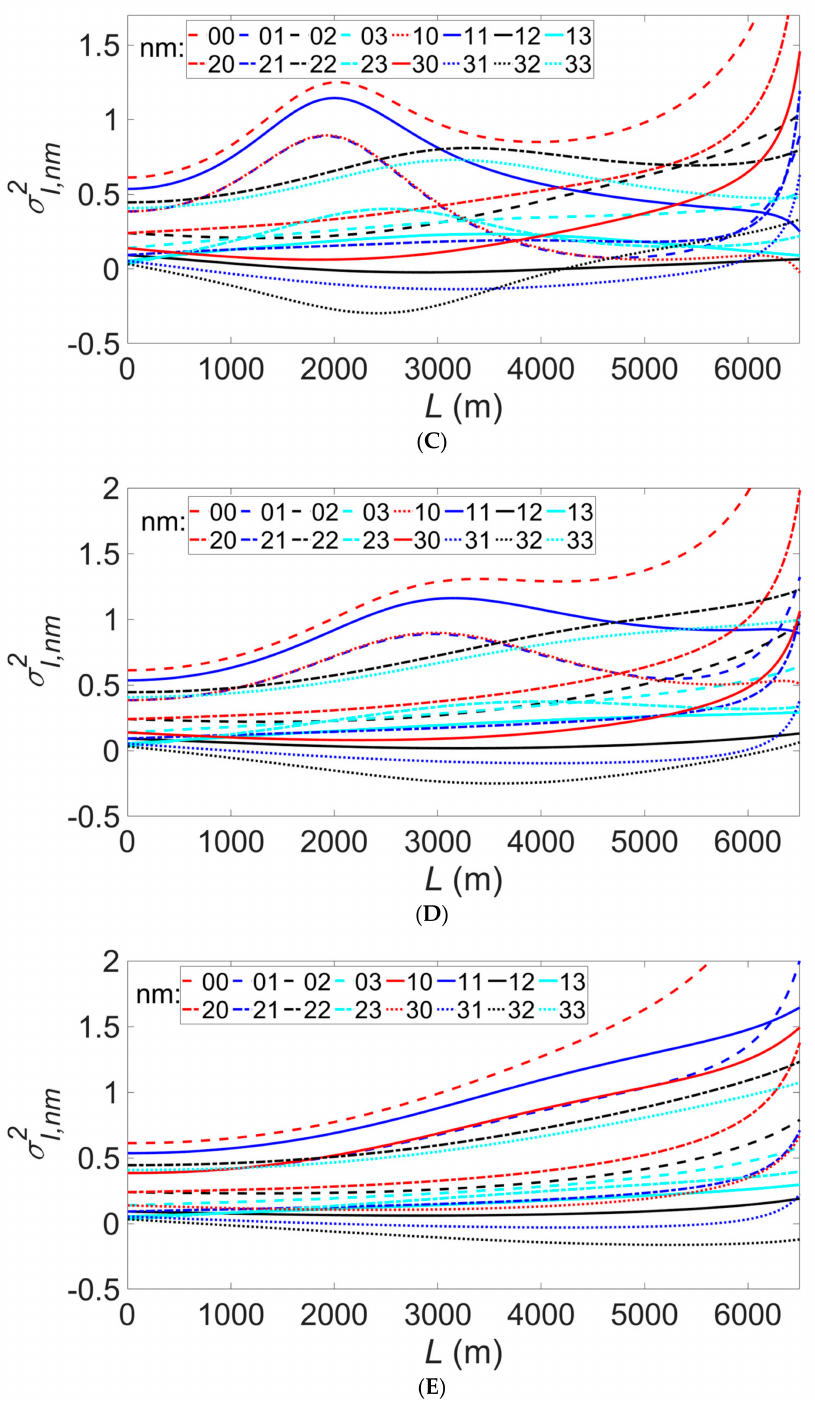
Figure 4. Scintillations versus propagation distance L for source correlation sizes: ( A ) 5 times greater; ( B ) 8 times greater; ( C ) 10 times greater; ( D ) 12 times greater; ( E ) 15 times